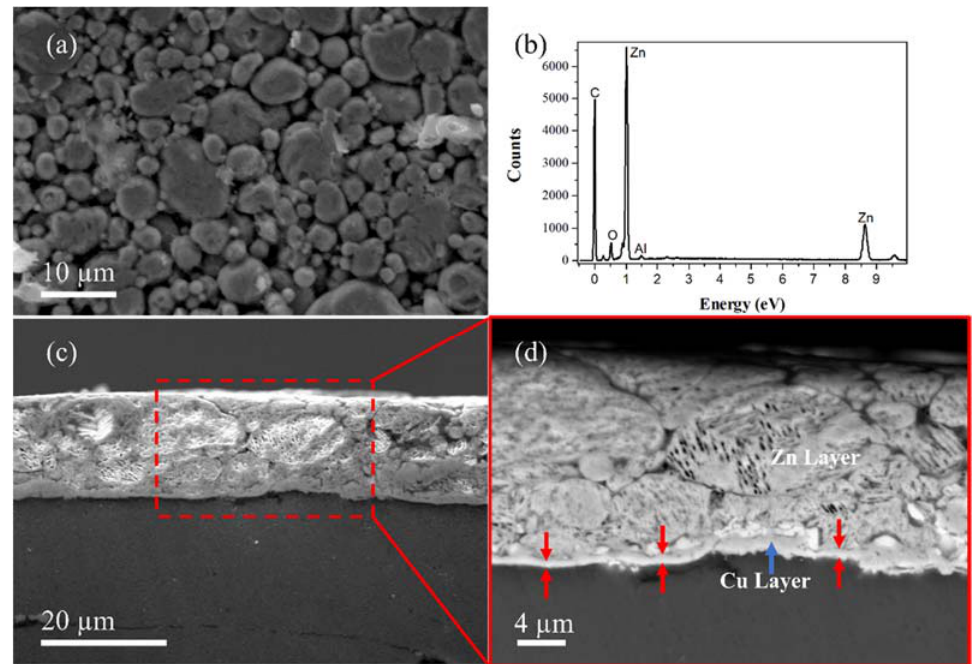
Figure 3. ( a ) SE ‐ SEM of coating surface finishing. ( b ) EDS ‐ SEM analysis of coating. ( c ) Cross ‐ section of coated nanocomposite and coating thickness. ( d ) Interface layer between the Al ‐ based nanocomposite surface and the Zn ‐ coated layer.